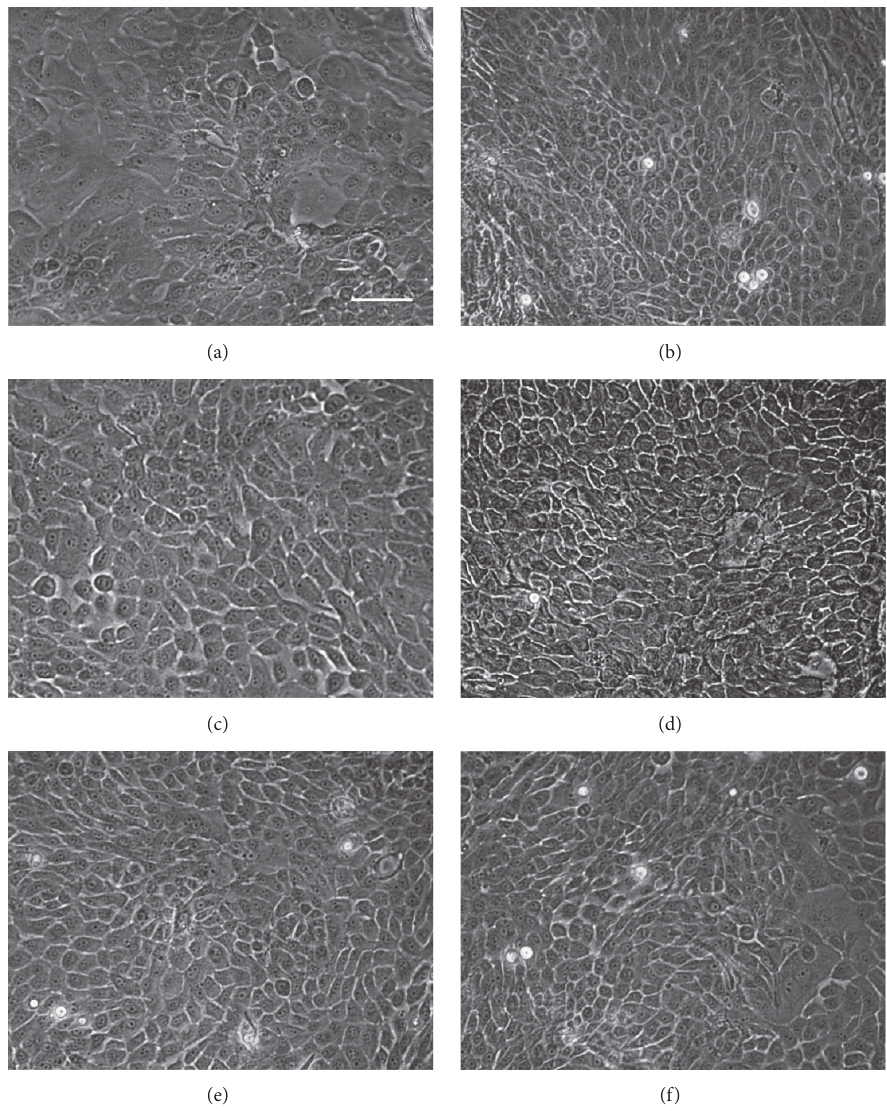
Figure 7: Representative micrographs of the morphology of LSC by donor age range at isolation passage. (a, b) Isolation passage of two donors aged < 60 years. (c, d) Isolation passage of two donors aged 60–75 years. (e, f) Isolation passage of two donors aged > 75 years. Scale bar = 20 𝜇